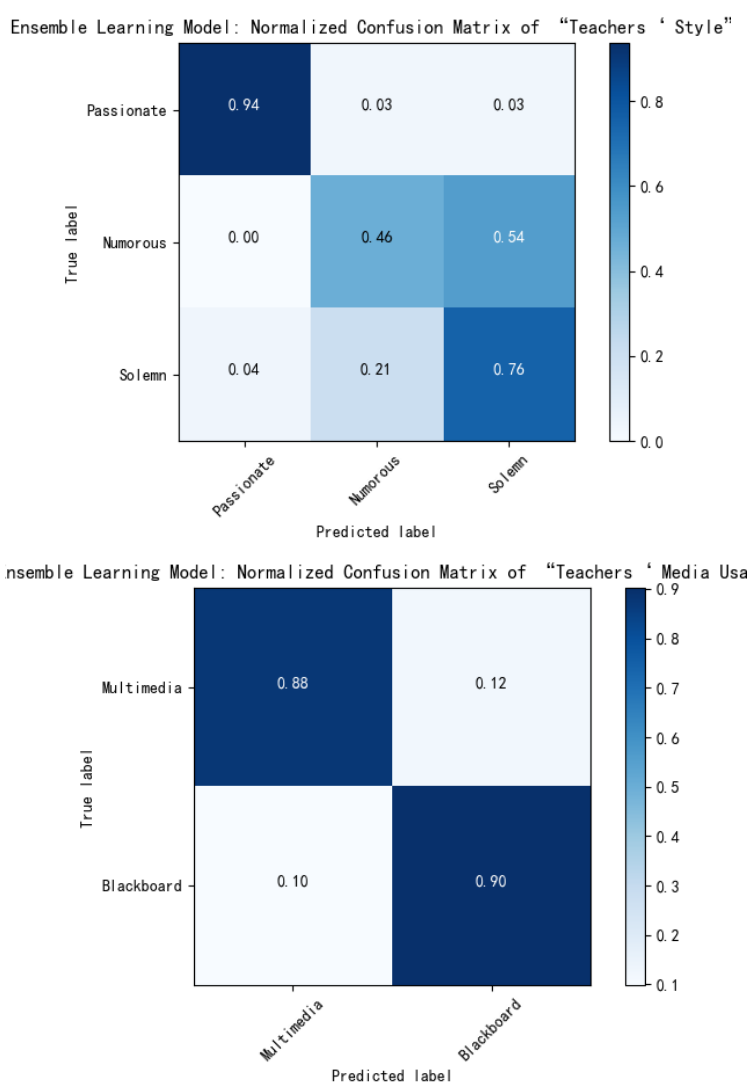
Figure 12. Confusion matrix for category indicators evaluated by the ensemble learning module.